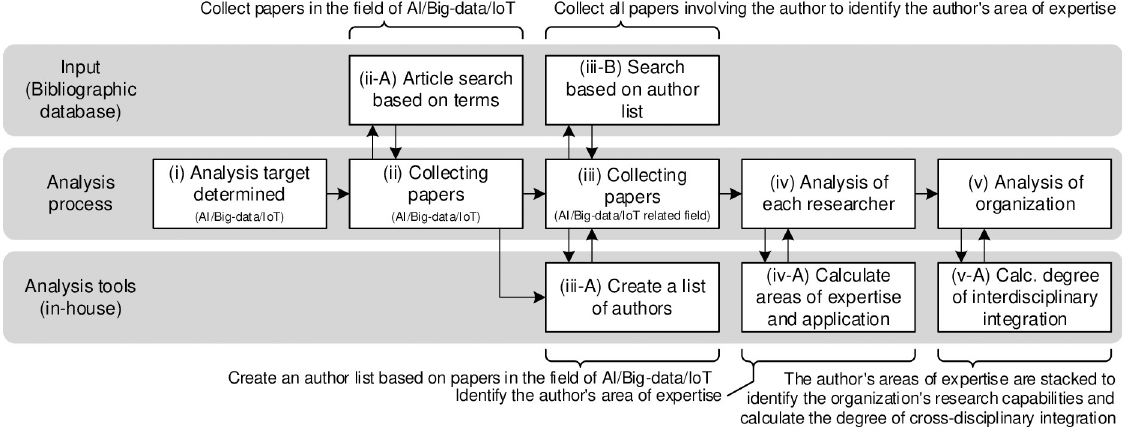
Fig 4. Procedure for analyzing an organization’s research capabilities and interdisciplinary integration. Note : Only the procedure of the first step is shown. The second step is to perform the analysis with the statistical analysis software "R".